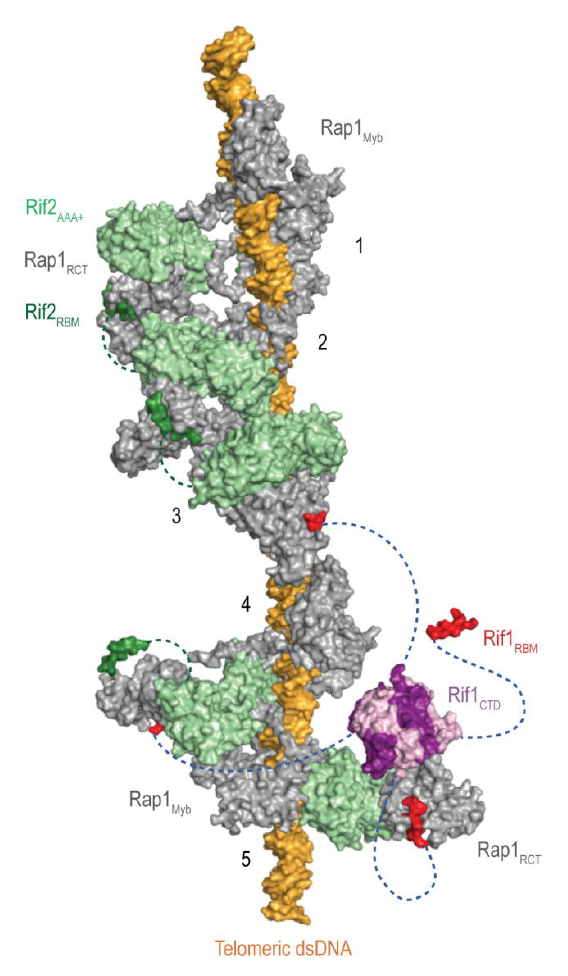
Figure 4: The Velcro-like protein network found at S. cerevisiae telomeres. Structural model illustrating the Rap1-Rif1-Rif2 inter- actions at dsDNA regions of budding yeast telomeres [29].